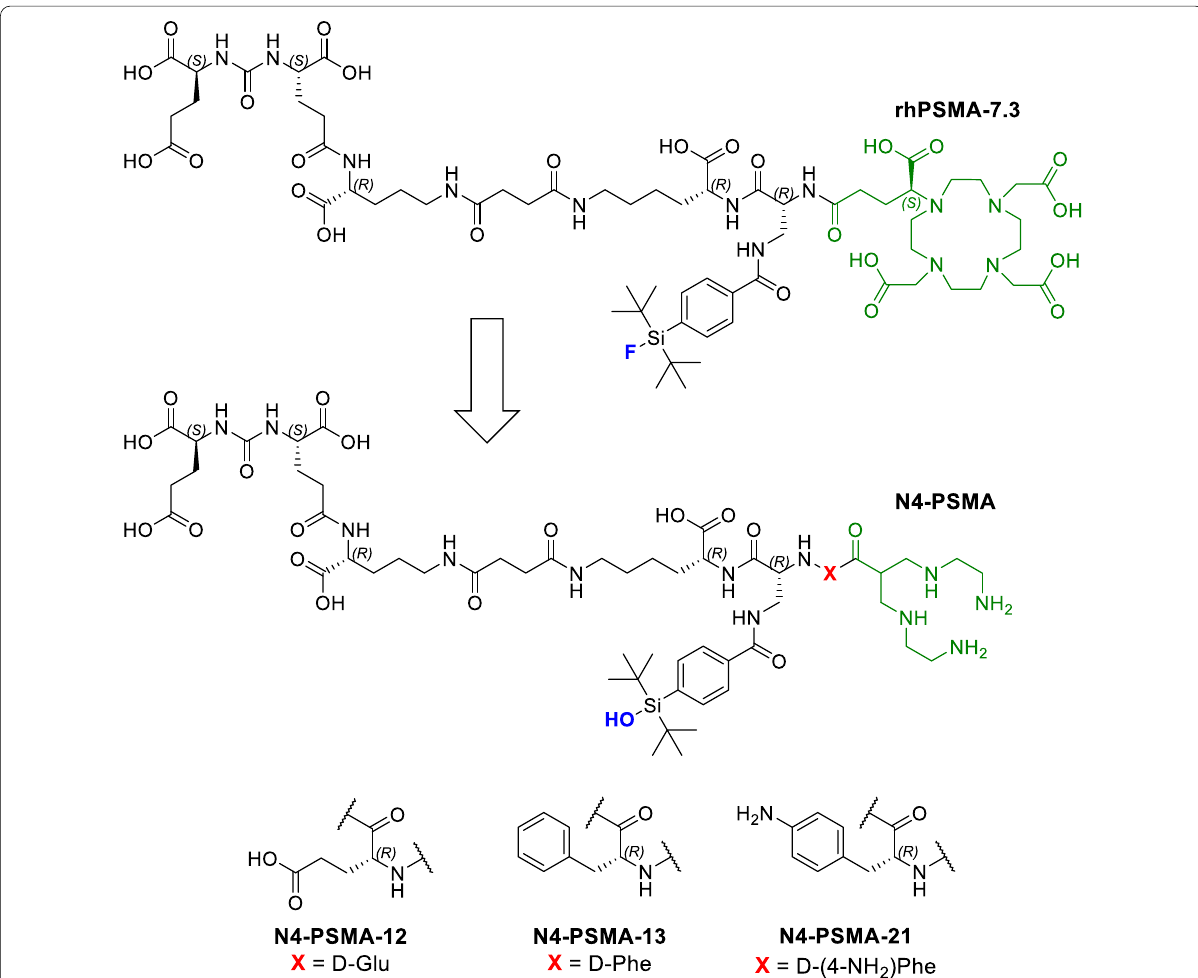
Fig. 1 Molecular structures of the novel N4‑PSMA ligands were derived from rhPSMA‑7.3 by substitution of ( S )‑DOTAGA with a tetraamine (N4) chelator for complexation of technetium‑99m (indicated in green) and incorporation of a less lipophilic, hydrolized derivative of the silicon fluoride acceptor‑moiety (indicated in blue). A variable amino acid (X, red) is introduced in N4‑PSMA‑12, N4‑PSMA‑13 and N4‑PSMA‑21 to modulate